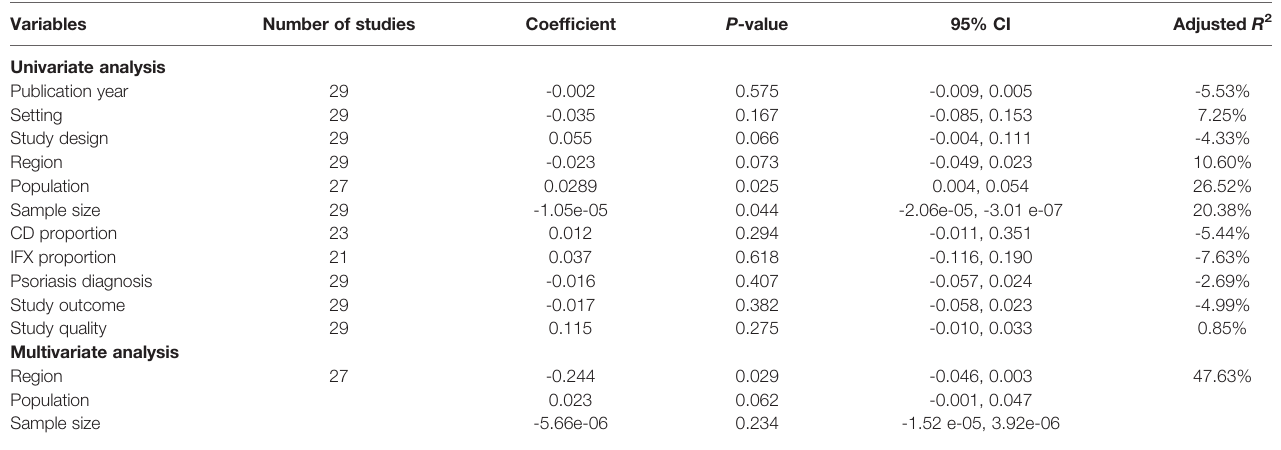
TABLE 2 | Meta-regression for the source of heterogeneity of pooled incidence.